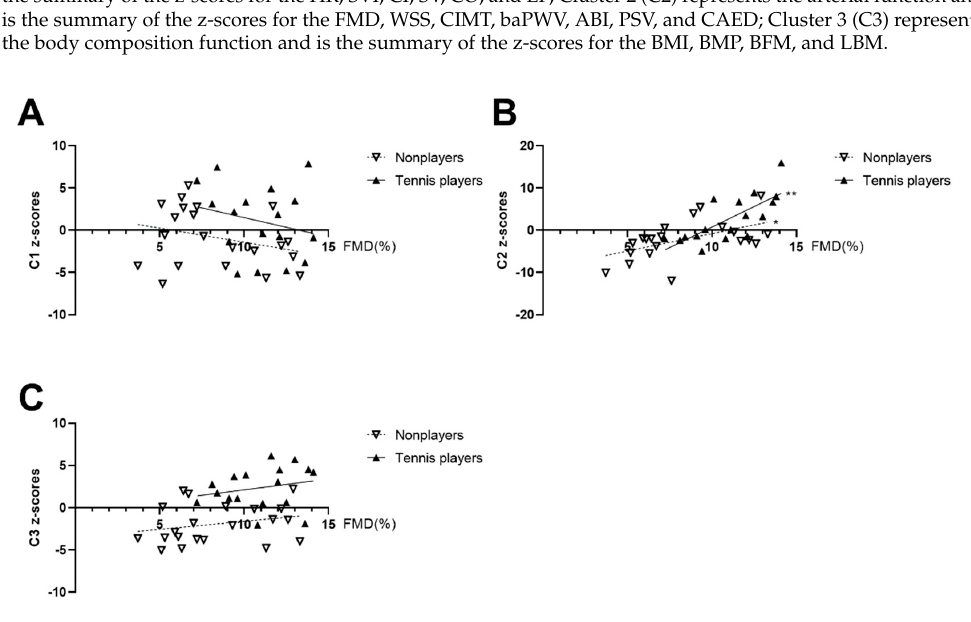
Table 7. Correlation between the FMD and Cluster 1, Cluster 2, and Cluster 3. Simple Correlation Analysis